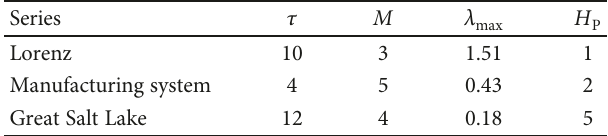
Figure 6: Power spectrum of GSL. Table 1: Characteristics of the series.